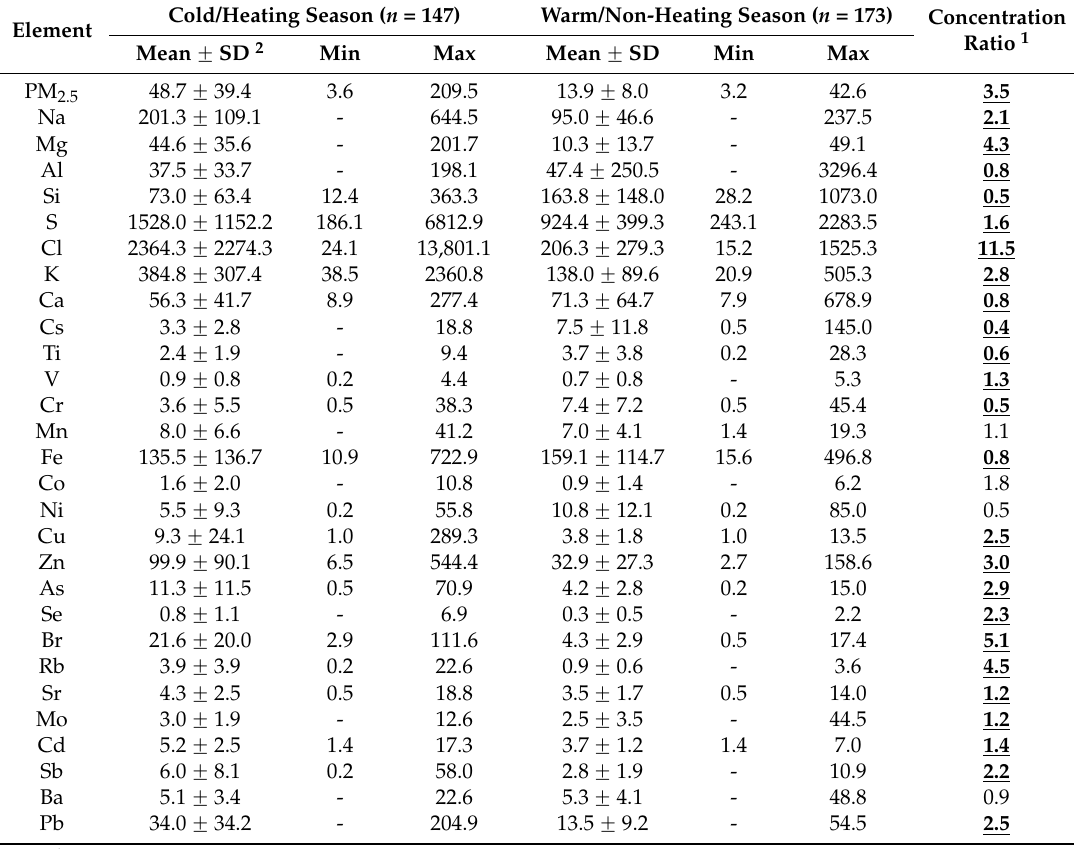
Table 2. Descriptive statistics of twenty-four-hour concentrations of PM 2.5 ( µ g ¨ m ´ 3 ) and PM 2.5 -bound elements (ng ¨ m ´ 3 ) in the warm and the cold seasons of 2011–2012 in Racibórz. Cold/Heating Season ( n = 147) Warm/Non-Heating Season ( n = Element